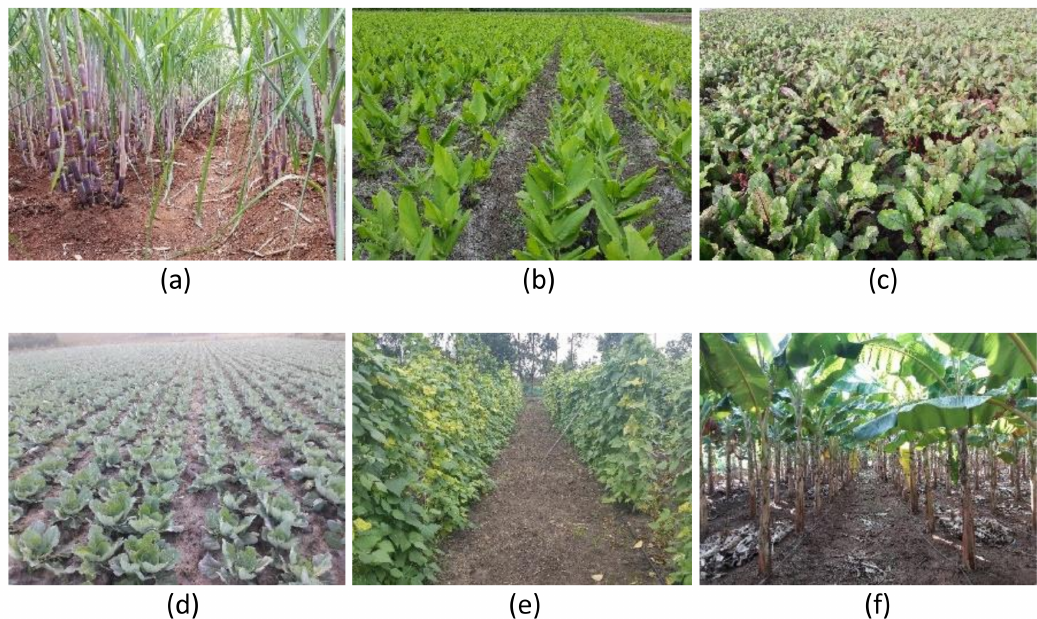
Figure A3. Examples of irrigated crops grown in the Berambadi watershed: ( a ) sugarcane, ( b ) turmeric, ( c ) beetroot, ( d ) cabbage, ( e ) beans, and ( f )